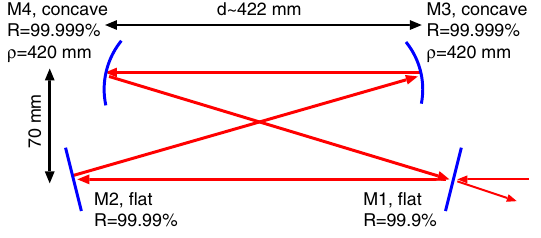
FIG. 7. Schematic of the bow-tie 4-mirror cavity.